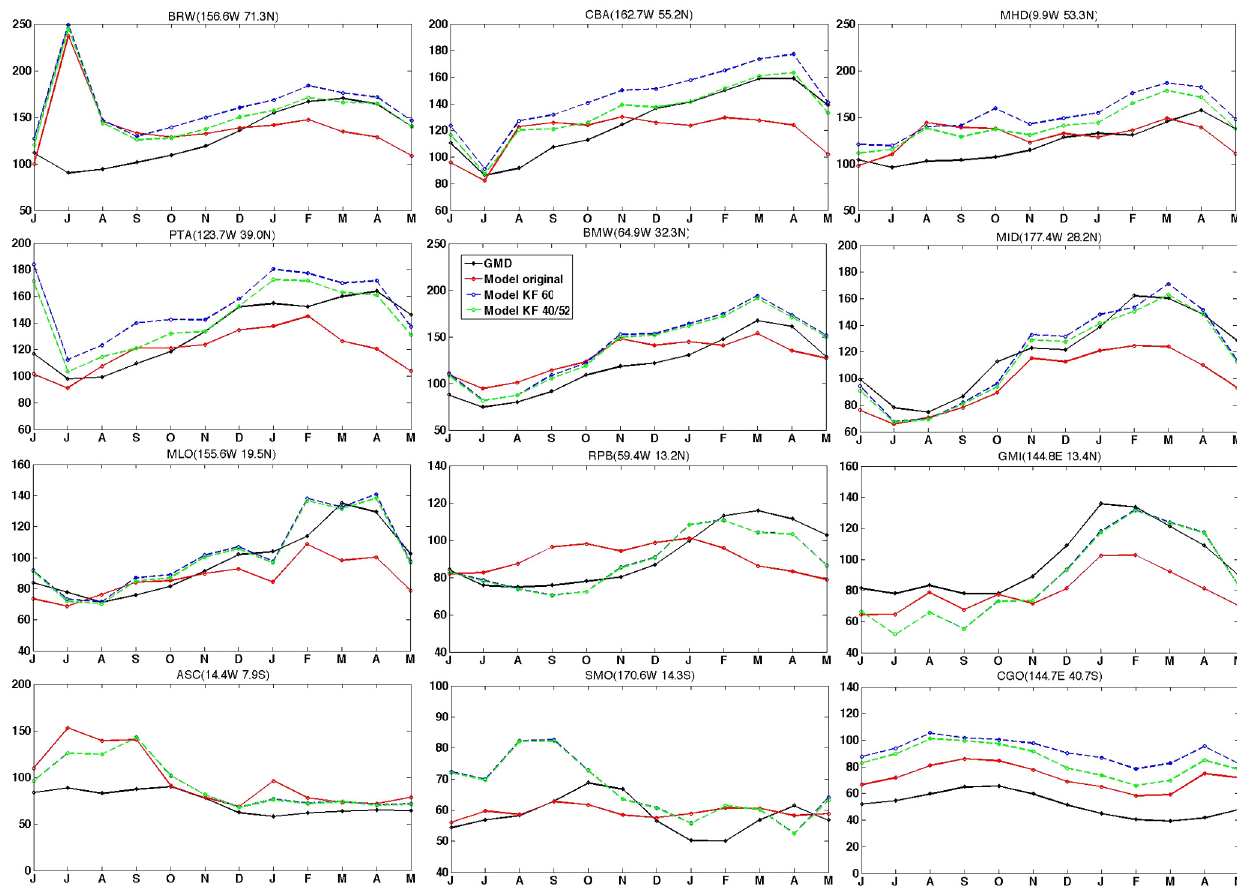
Figure A1. Annual variation of monthly mean CO concentration at selected GMD sites and surface level CO in GEOS-Chem, sampled at the GMD sites. The black solid line shows the GMD monthly mean CO. The red solid line shows the free model simulation with original initial condition. The blue dashed line is the assimilation result using MOPITT from 60 ◦ S to 60 ◦ N. The green dashed line is the assimilation result from excluding the high latitude